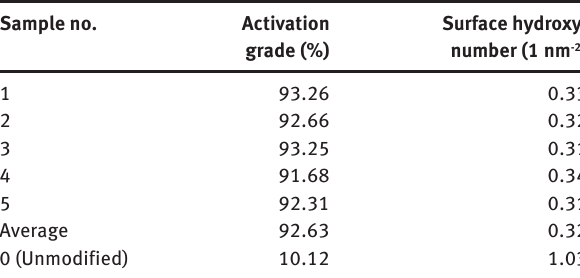
Table 6 Optimized parallel experiments results. Sample